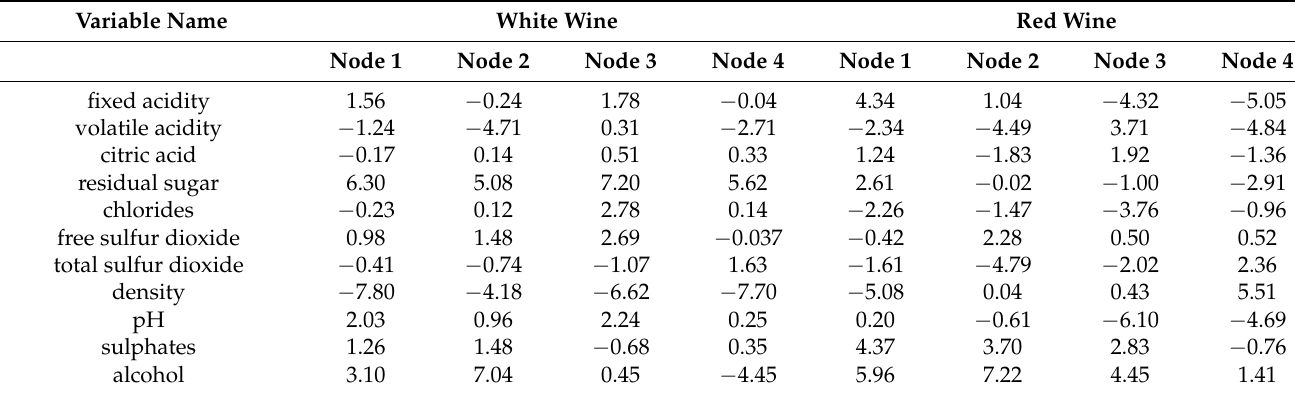
Table 4. Projection pursuit coefficients in each node for the white and red